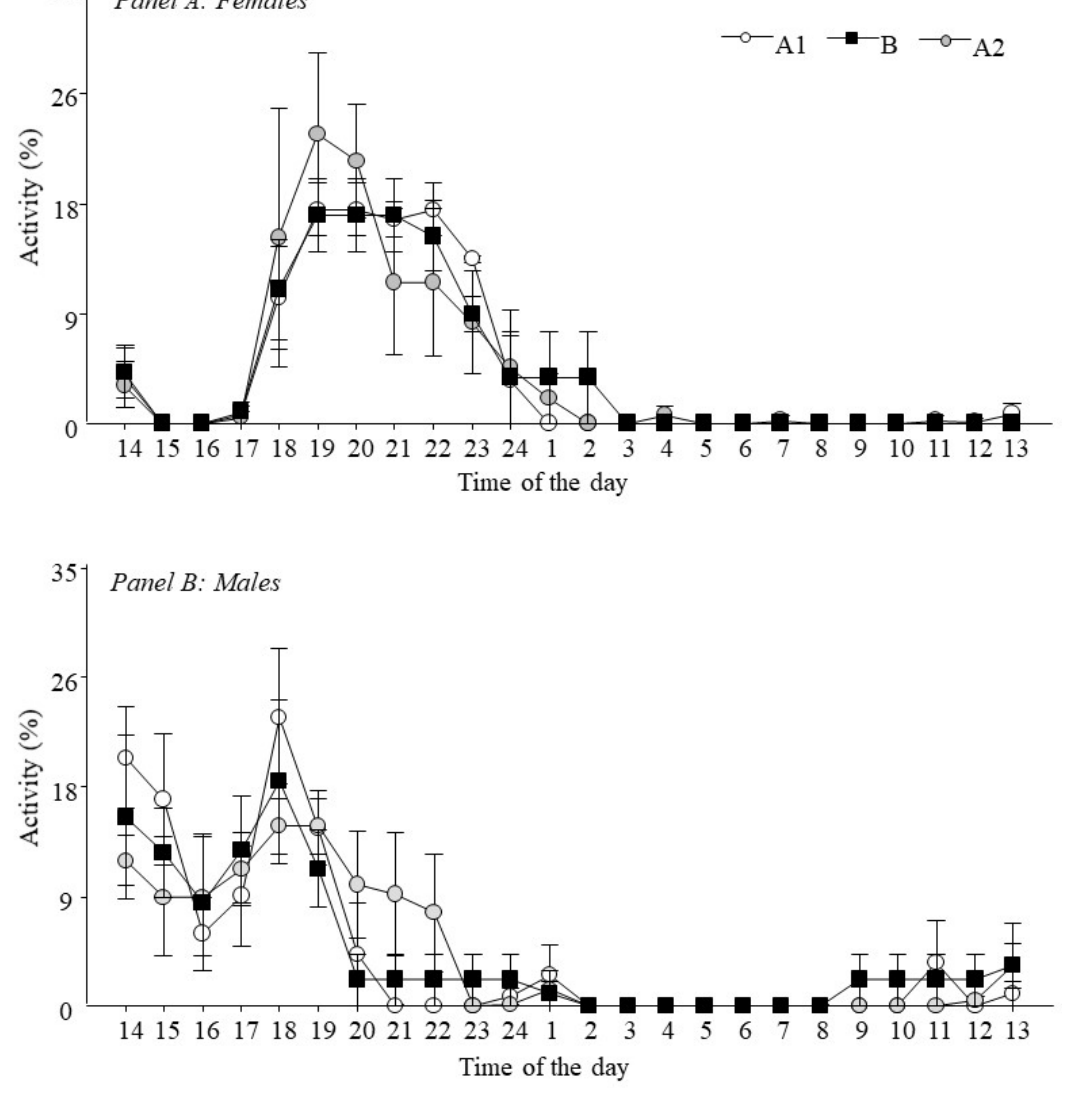
Figure 4. Percentage of activity per hour of adult Tamandua tetradactyla (n = 3 females, Panel A; 3 males, Panel B) exposed to semi-controlled conditions during ABA stages. Behaviour was recorded continuously for 3 consecutive days (A1: baseline, without vest; B: treatment, vest on; A2: posterior, without vest). The beginning of the X axis corresponds to feeding time.